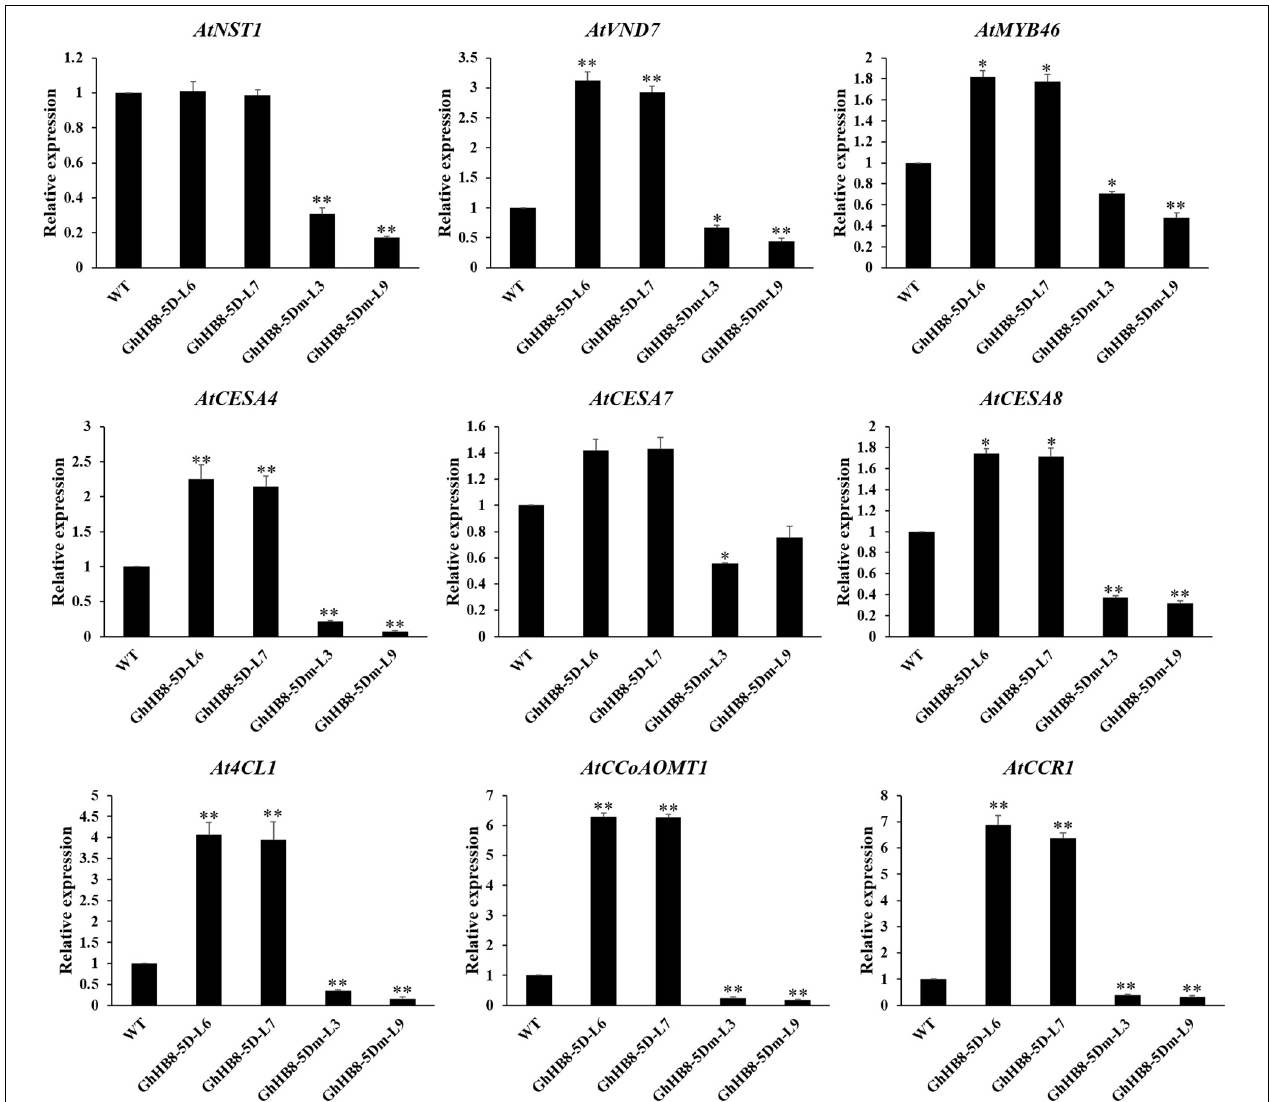
FIGURE 9 | Expression of secondary wall-related genes in 6-week-old stems of wild type and transgenic lines. The AtActin2 was used as an internal control for normalization. Values represent the mean ± SD of three biological replicates. Student’s t -tests demonstrated that there were significant differences ( ∗ p < 0.05, ∗∗ P < 0.01) between the transgenic lines and the wild